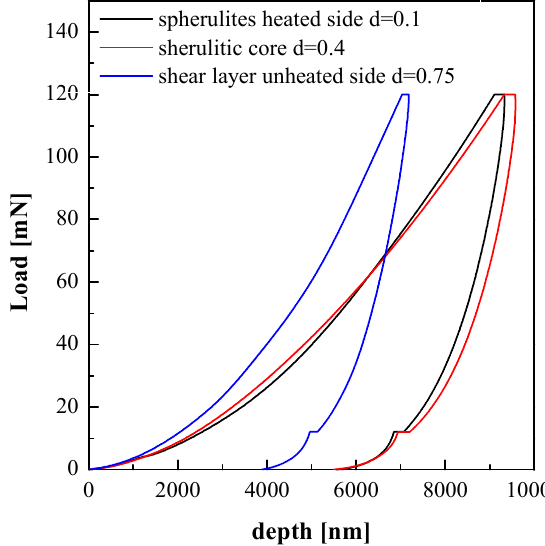
Figure 7. Load-displacement curves of three different positions along the thickness of sample 120-18.